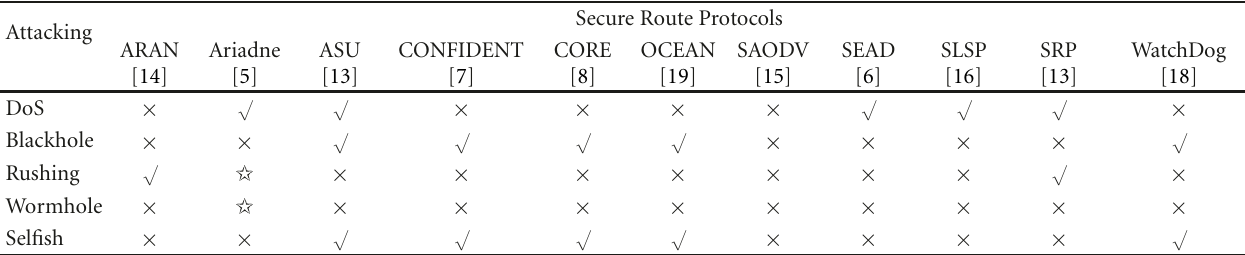
Table 1: Comparison of Secure Routing Protocols.